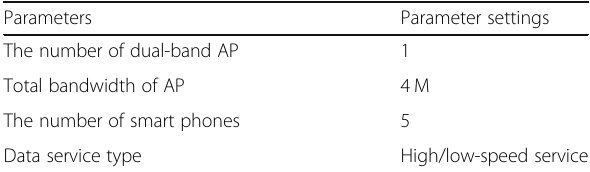
Table 1 Experimental setup Parameters